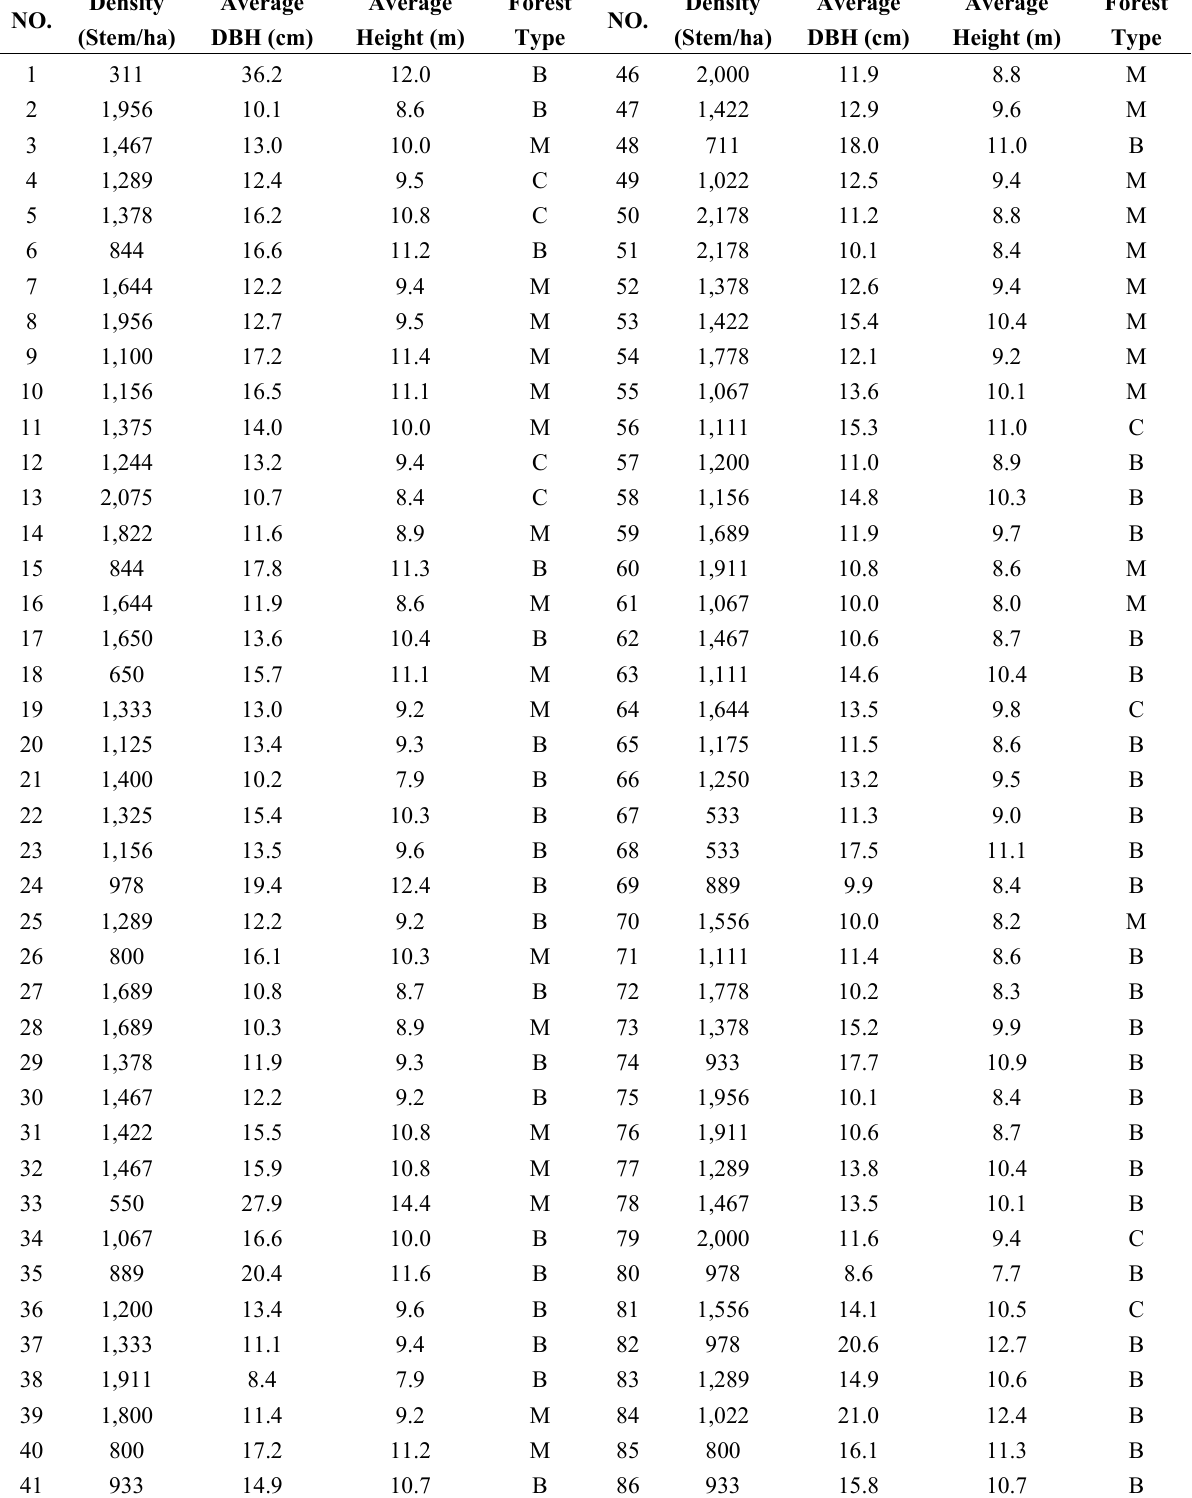
Table 1. The condition of the 90 plots surveyed in September, 2011. DBH, diameter at breast height. B, broad-leaved; M, mixed; C,